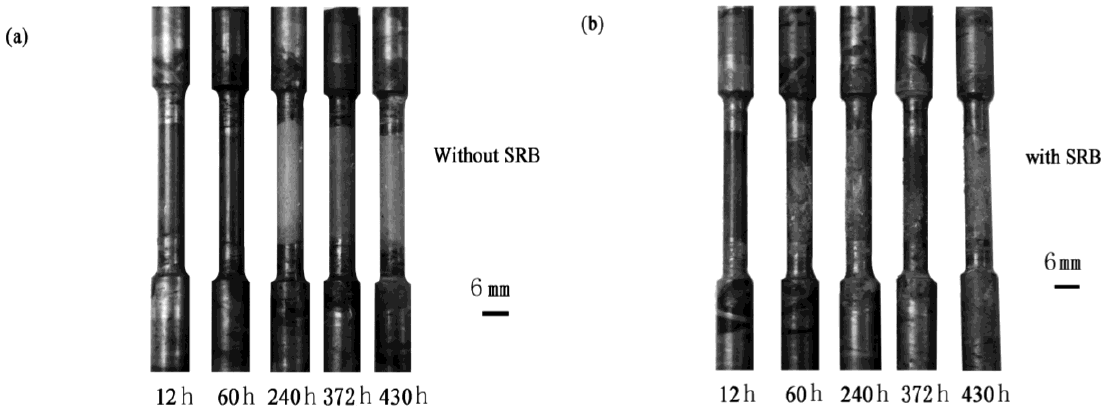
Figure 2. Morphology of the corrosion product of the test bars ( a ) in sterile corrosion medium; and ( b ) in sulfate-reducing bacteria (SRB) corrosion